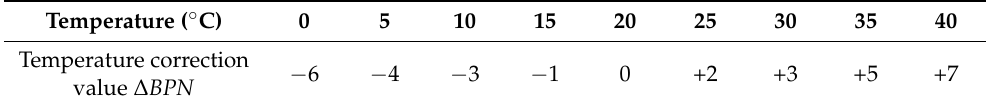
Table 4. Temperature correction values for the pendulum